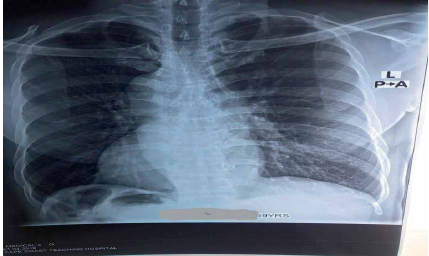
Figure 5: Frontal chest radiograph. It shows the apex of the heart pointing to the right, ascending and arch of the aorta on the right, gastric air bubble and splenic flexure both on the right side under the diaphragm opposite of the normal anatomical